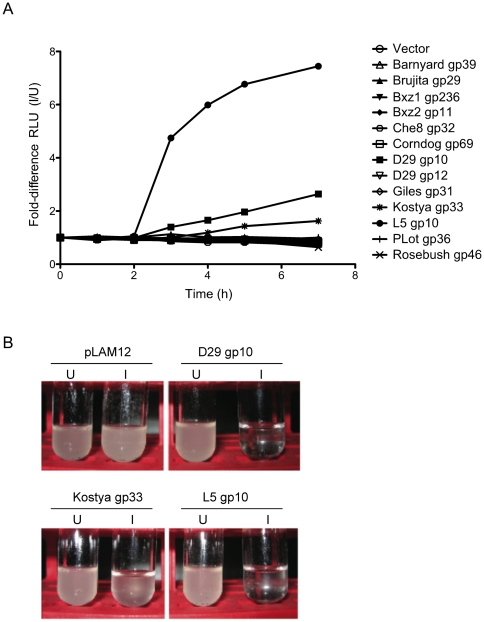
ATP release upon induction of lysin expression.Cultures of M. smegmatis mc2155 carrying pLAM12-based plasmids with different lysins were split and half were induced with 0.2% acetamide. A. ATP release was measured for 7 hours and the fold-difference between induced and uninduced ATP release calculated for each lysin and plotted versus the time. B. After more than 16 hours of induction several of the cultures had lysed completely.